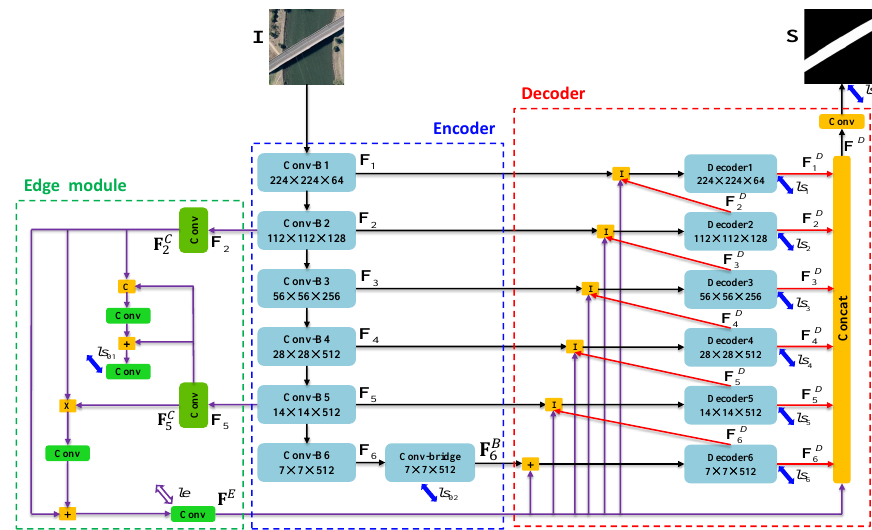
Figure 1. Illustration of the proposed saliency